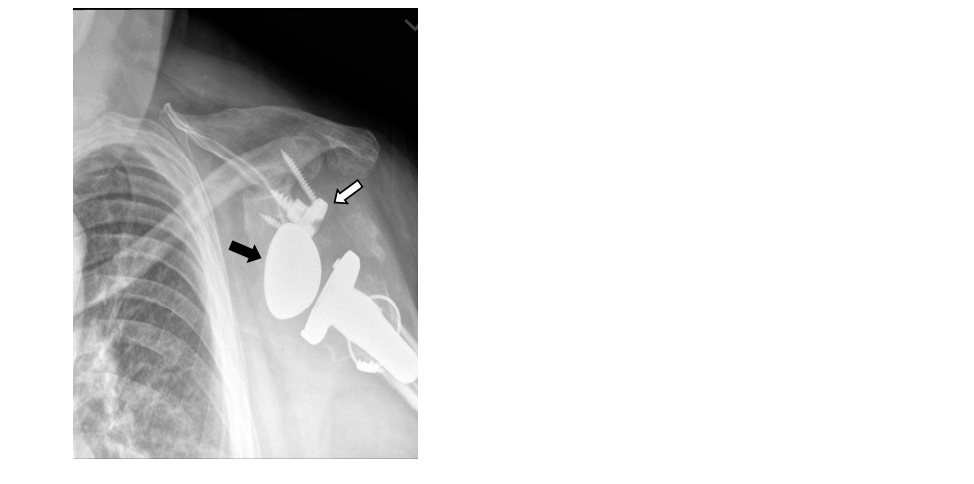
Figure 25. Frontal radiograph in a patient with RTSA shows dissociation of the metaglene/baseplate (white arrow) and the glenosphere (black arrow).